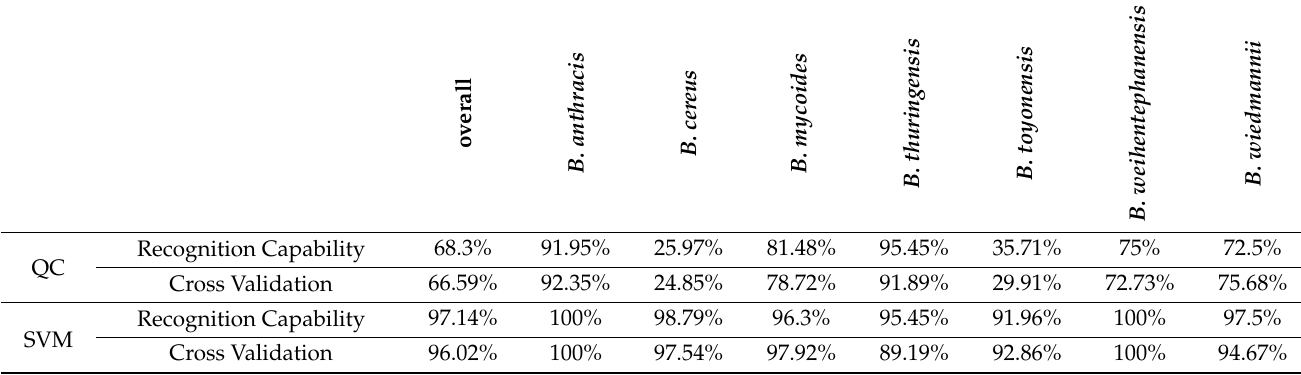
Table 2. Results of ClinProtools statistical model quick classifier (QC) and Support Vector Machine (SVM) in terms of Recognition Capability and Cross Validation for overall and single Bacillus species